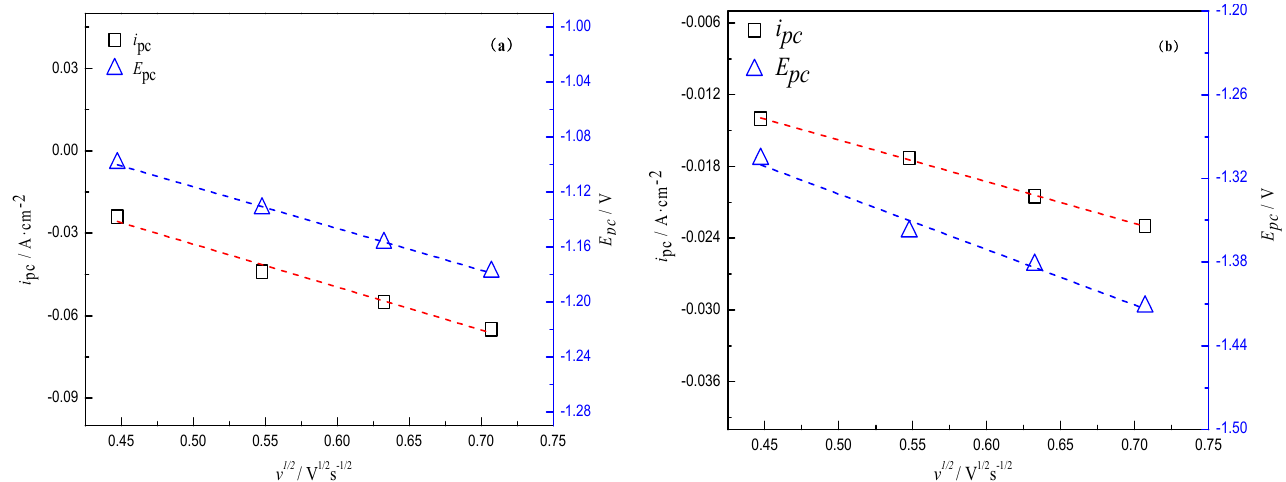
Figure 7. Relationship between i pc – v 1/2 and E pc – v 1/2 of Pt electrode in NaCl-CaCl 2 -LiMn 2 O 4 molten salt: ( a ) peak a ; ( b ) peak b .